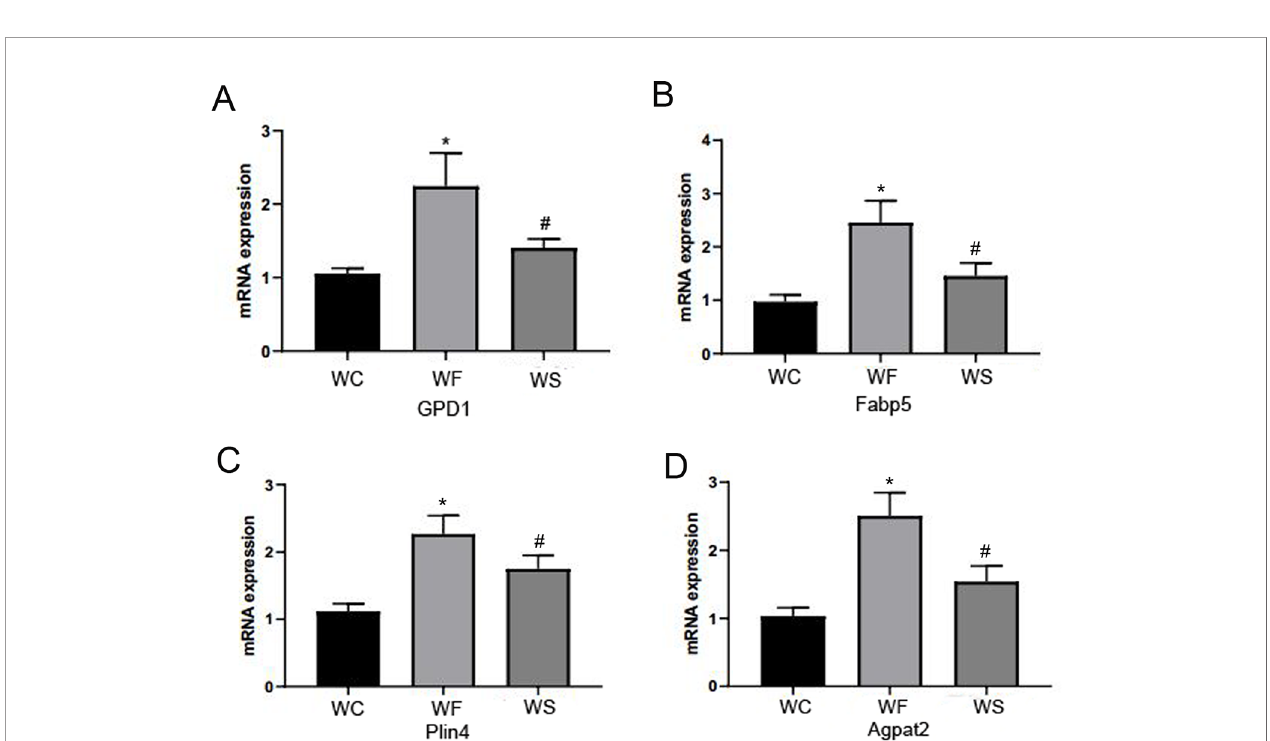
FIGURE 11 | Silibinin down-regulated the mRNA expression of GPD1, Fabp5, Plin4, and Agpta2. (A) The mRNA expression of GPD1; (B) The mRNA expression of Fabp5; (C) The mRNA expression of Plin4; (D) The mRNA expression of Agpat2. *P < 0.05 vs WC, # P < 0.05 vs